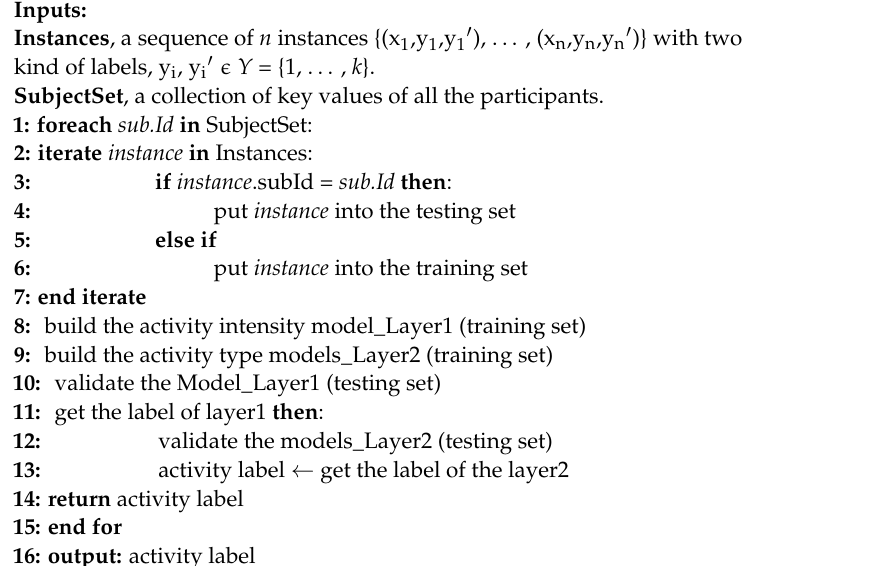
Algorithm 1: The pseudo-code of cascade classifier based on multi-label (CCM)